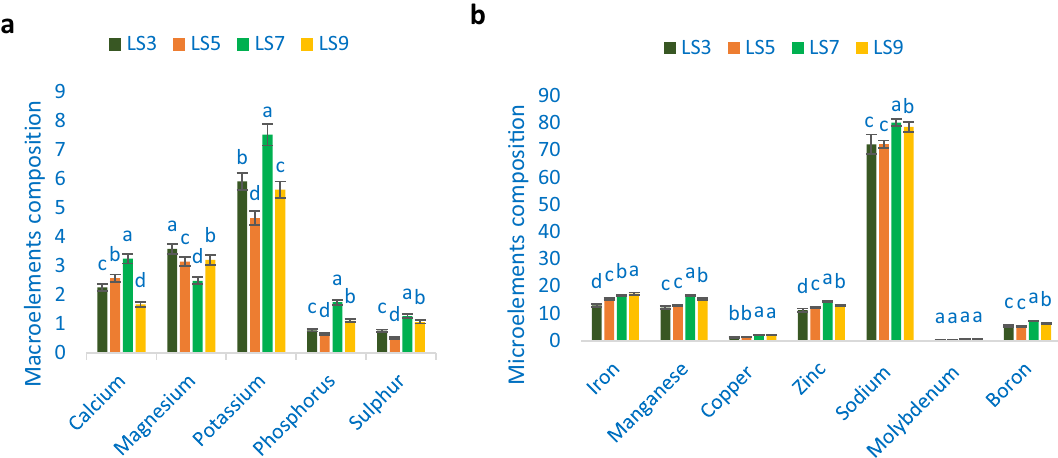
Figure 7. Minerals compositions ( a ) Macroelements (mg g −1 FW) ( b ) Microelements (µg g −1 FW) in four selected A. gangeticus leafy vegetables, different letters are differed significantly by Duncan Multiple Range Test (P < 0.01), (n = 3).